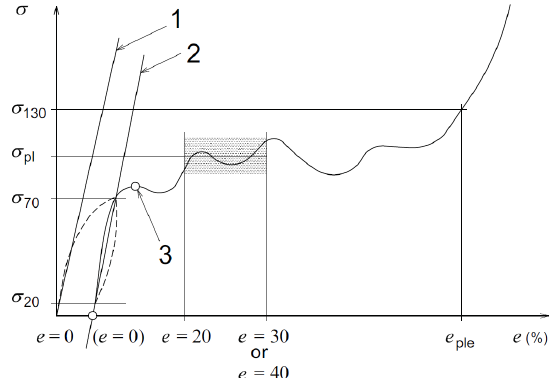
Figure 5. Stress-strain curve to determine the char- acteristic values from compression testing of porous and cellular metals [5]. Grayed out area in the graph represents the plateau stress, from which the mean value of σ pl is calculated. The plateau stress is a mean value of stress calculated from stress values in between the range of strain e = 20% and e = 30%. σ 70 and σ 20 then represent a range of values for caluculation of Young’s modulus of the entire structure by the least squares